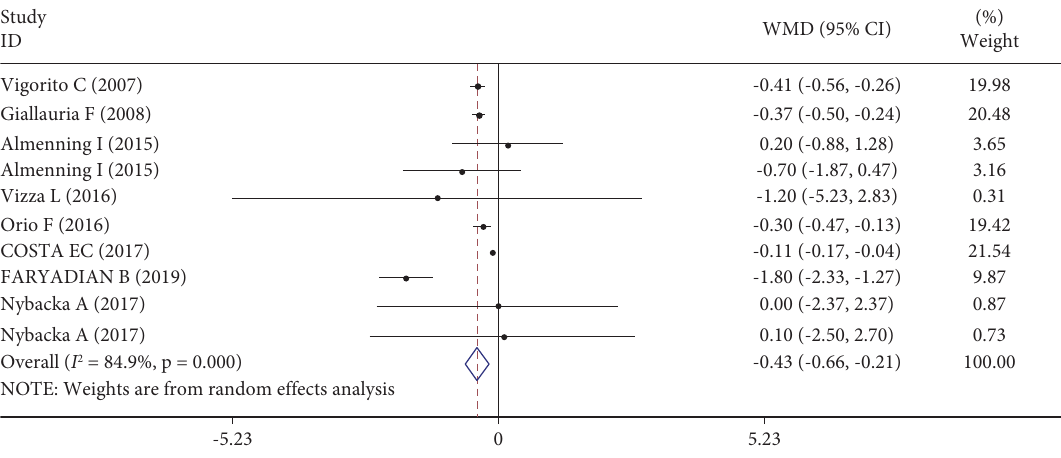
Figure 2: Forest plot for CRP studies ( n � 10). Te graph depicts WMD and 95% CI for individual studies and the pooled estimate.